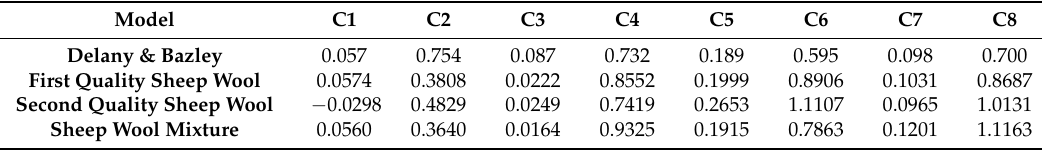
Table 5. Values of coefficients C i